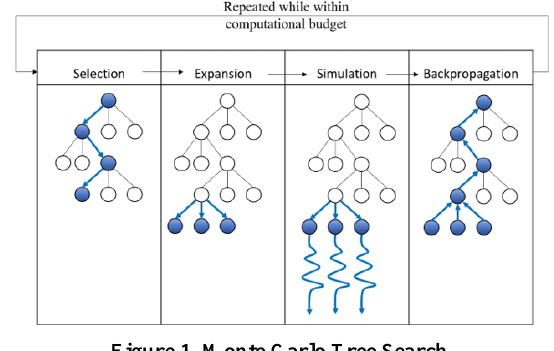
Figure 1. Monte Carlo Tree Search.